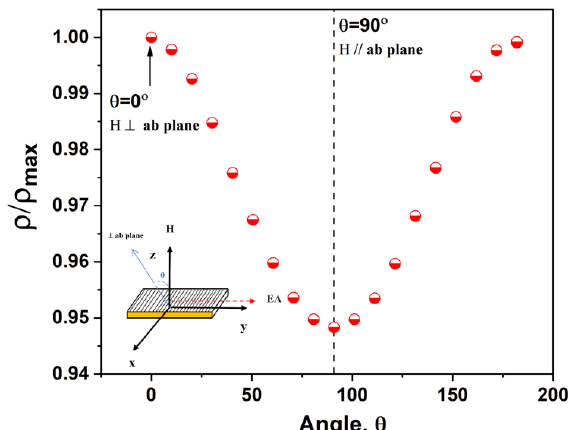
Figure 8. Angular dependence of the ( ρ / ρ max ) of LBMTO-5/STO system in a magnetic field of 5 T and at a temperature near the metal–semiconductor transition (250 K). Inset: schematic view of the measurement with the sample rotating in the in-plane (parallel) and the out-of-plane (perpendicular) geometry.